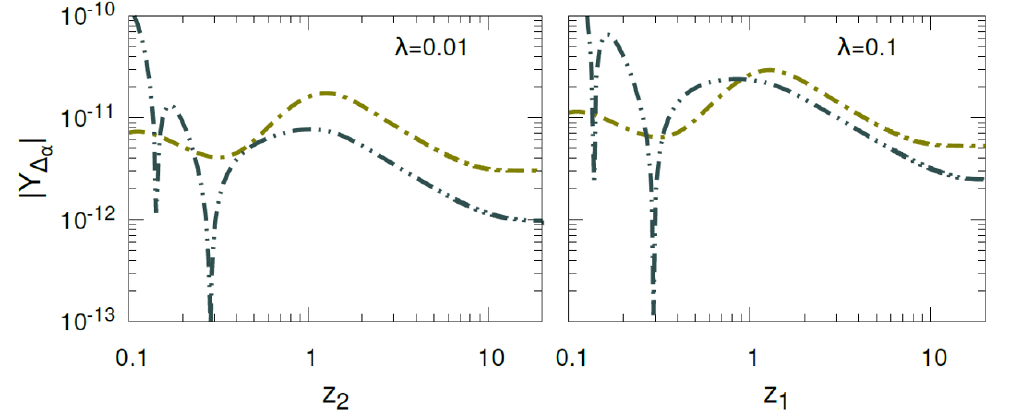
Figure 12 . The asymmetry with e + (cid:22) (cid:13)avors (double-dot-dashed blue curve) and the (cid:28) (cid:13)avor (dot-dashed curve) due to N 2 decay. The left (right) panel represents our estimations for quartic coupling (cid:21) = 0 : 01(0 : 1).